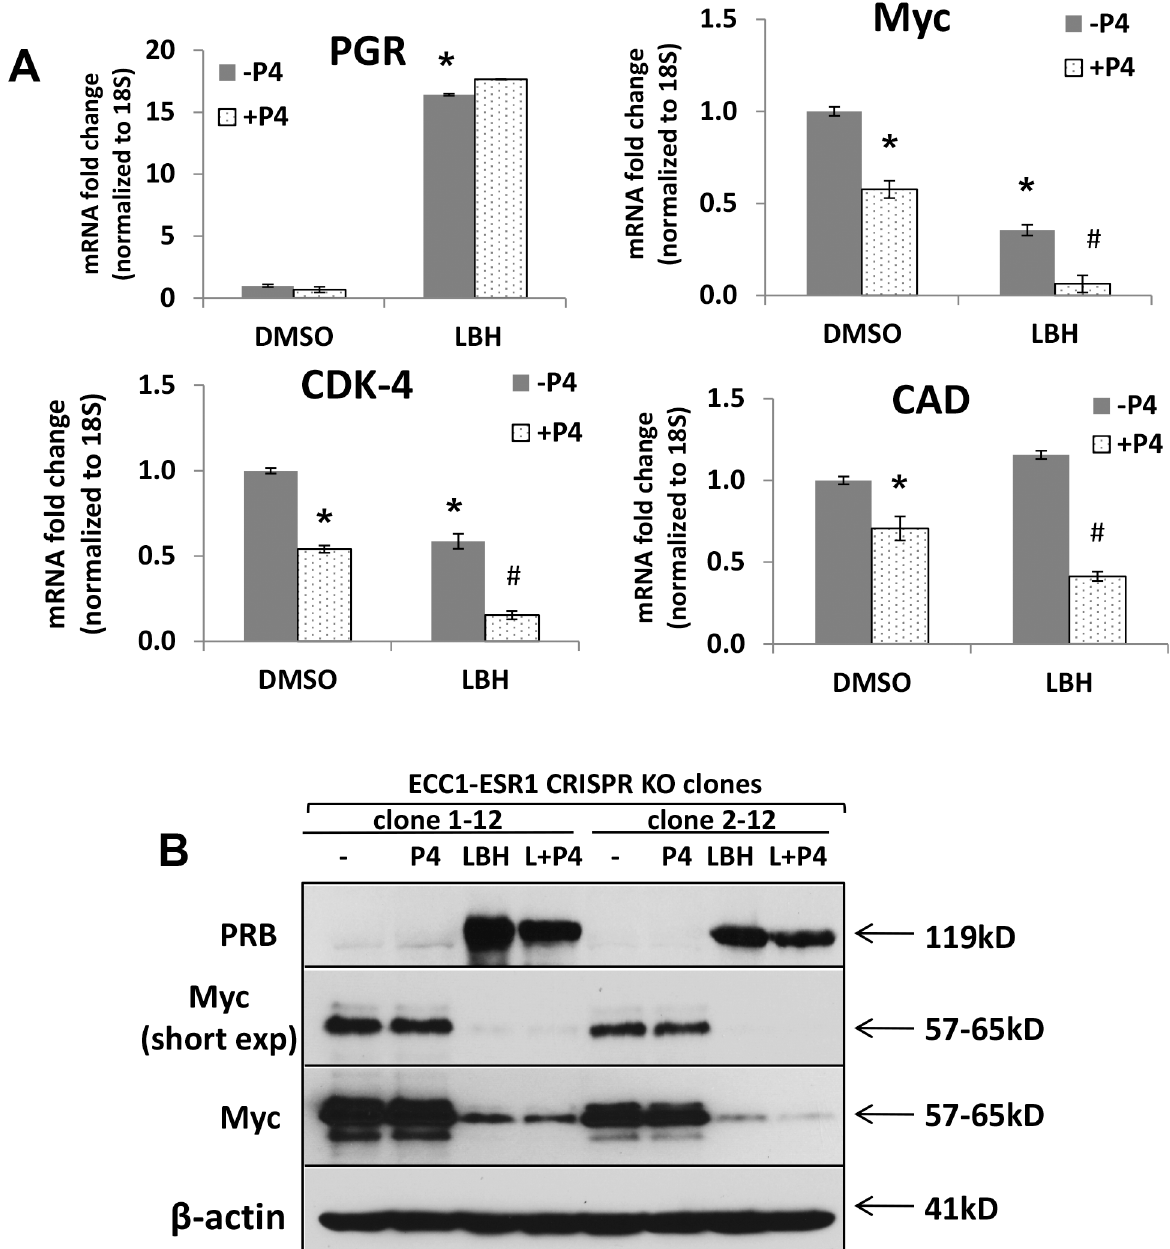
Fig 5. Downregulation of Myc and downstream target genes in response to HDACi alone and in combination with progesterone. (A) ECC1- ESR1 CRISPR KO clone 1 – 12 was treated with 100 nM P4 for 16 hr, 20 nM LBH589 for 24 hr, or the combination, followed by analysis of PR, Myc, and PR target genes by qRT-PCR. Data were normalized to 18S and calculated as the fold change relative to control. Results are representative of 3 independent experiments; * p < 0.05 vs. DMSO; # p < 0.05 vs. LBH589. (B) ECC1- ESR1 CRISPR KO clones were treated as in (A), followed by analysis of PR and Myc protein levels by Western blotting. β -actin serves as a loading